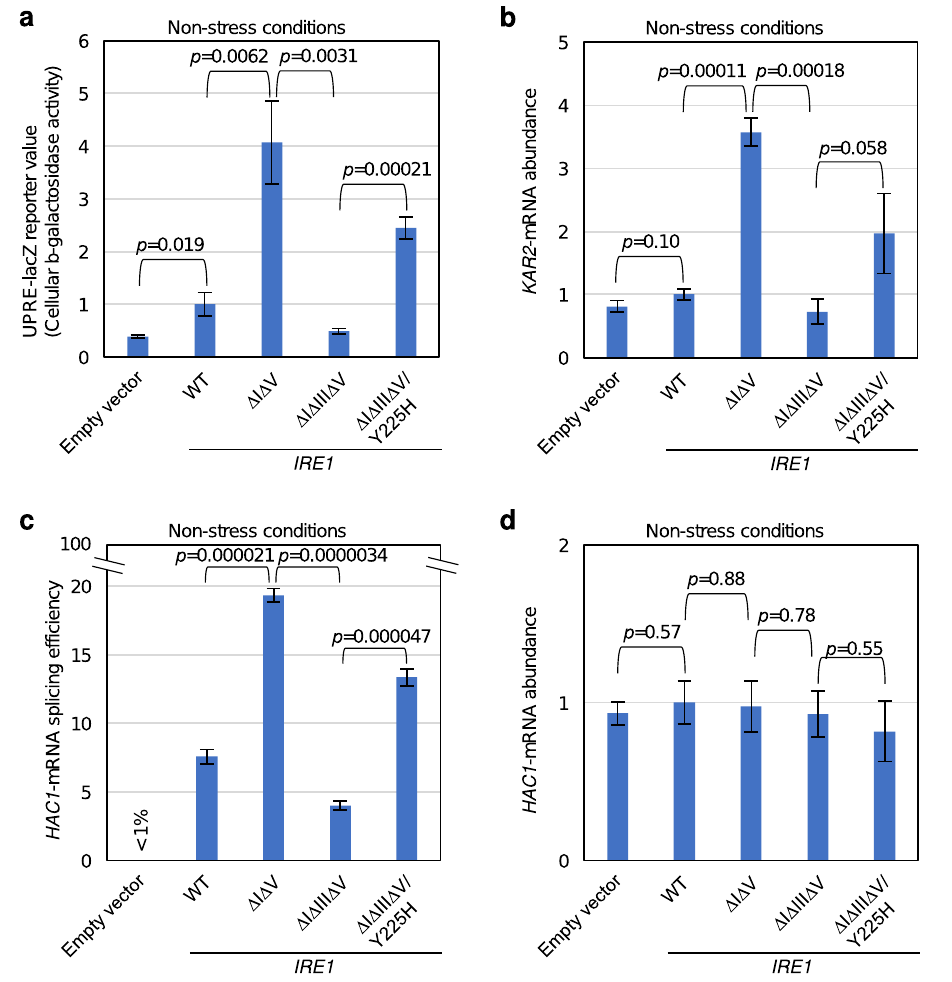
Figure 1. Isolation of the Y225H mutation as an intramolecular suppressor of the low-activity phenotype of ΔIΔIIIΔV Ire1. KMY1015 cells ( ire1Δ ) bearing the UPRE-lacZ reporter plasmid, pCZY1, were transformed with the IRE1 plasmid, pRS315-IRE1-HA (wild-type: WT), or with that carrying the indicated mutations (or with the empty vector, pRS315), and were grown at 30 °C in SD medium. ( a ) The cultures were subjected to measurement of cellular β-galactosidase activity. ( b ) Total RNA samples were subjected to RT-qPCR analysis to monitor KAR2 -mRNA abundance. ( c ) Total RNA samples were subjected to RT-PCR to monitor HAC1 -mRNA splicing. ( d ) Total RNA samples were subjected to RT-qPCR analysis to monitor total HAC1 -mRNA abundance. In panels ( a ), ( b ), and ( d ), the values are normalized against that of wild-type (WT) IRE1 cells, which is set at